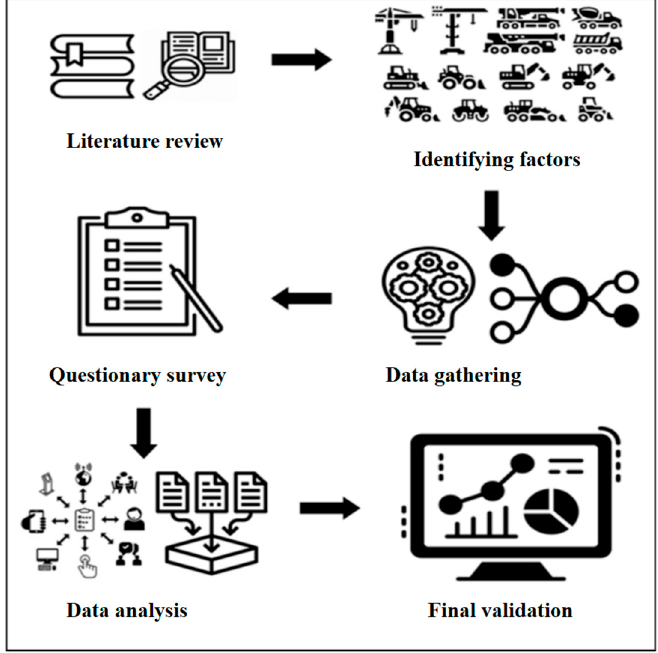
Figure 1. Methodology used in this